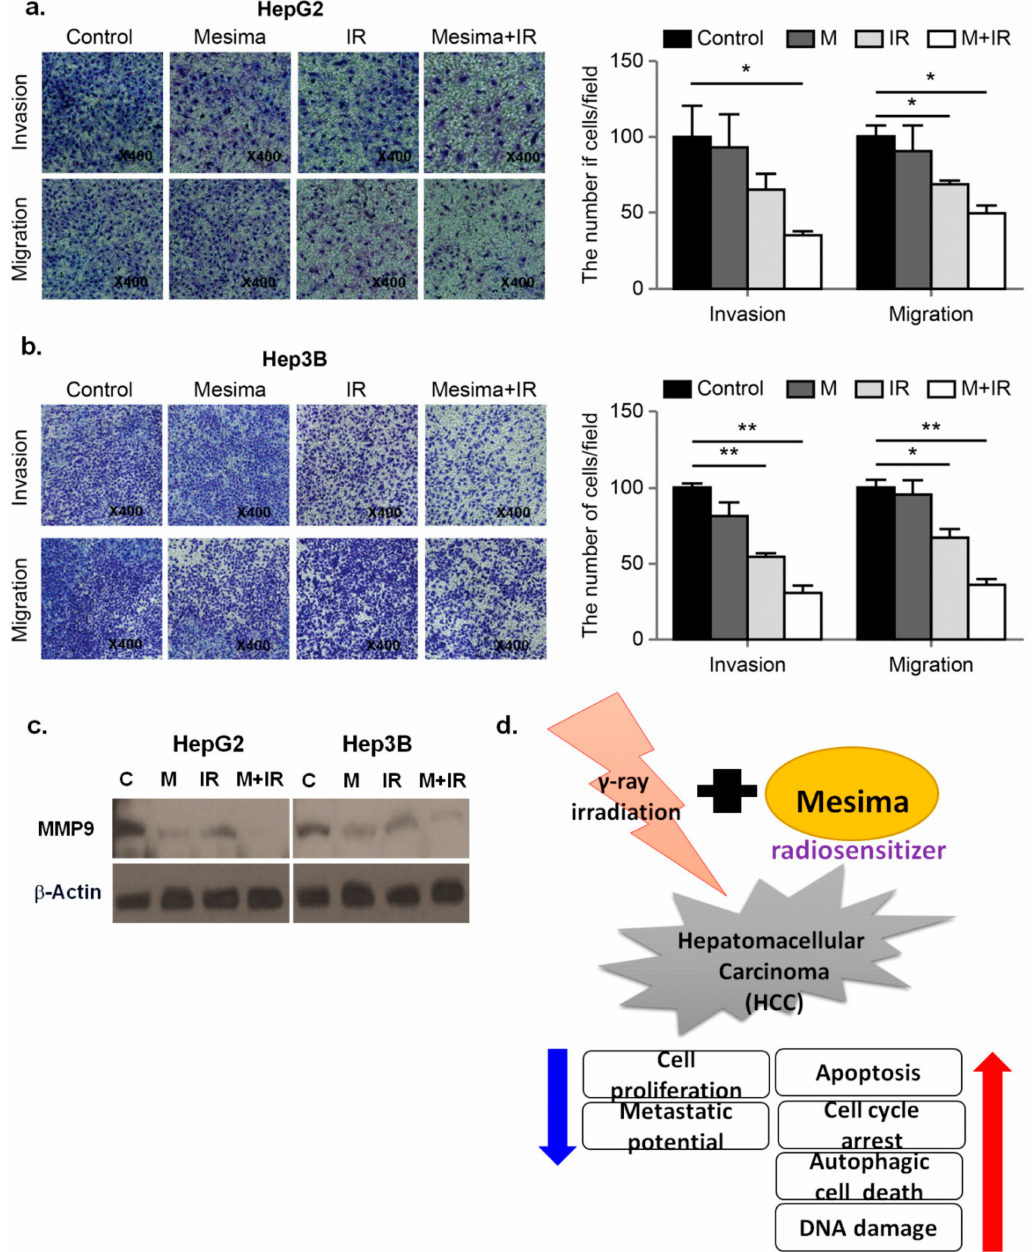
Figure 5. E ff ect of treatment with mesima and radiation on the invasion and migration of HCC cells. ( a , b ) HCC cell invasion and migration after 24 h mesima + radiation treatment were conducted by Transwell chamber assays; * p < 0.05; ** p < 0.01. ( c ) Cell lysates (30 µ g) of HCC cells were immunoblotted with MMP-9. ( d ) The proposed mechanisms for mesima as a radiosensitizer of HCC